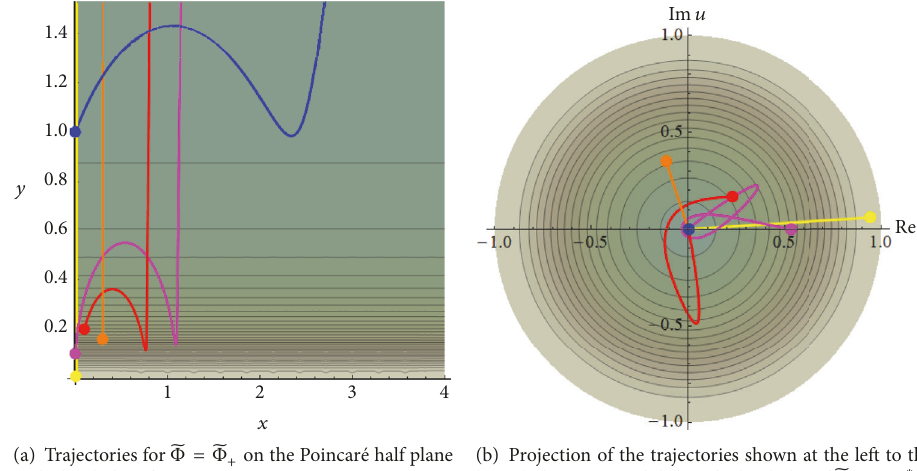
Figure 8: Numerical solutions for Φ = Φ − and 𝛼 = 𝑀 0 /3 .